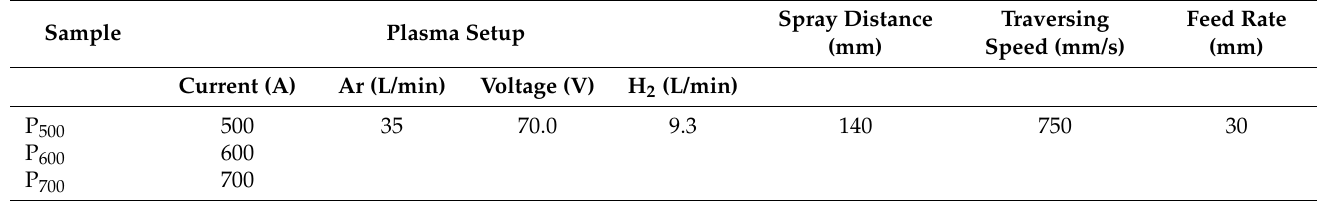
Table 1. Parameters of the plasma-spraying process for the Al 0.5 CoCrFeNi 2 Ti 0.5 coatings.